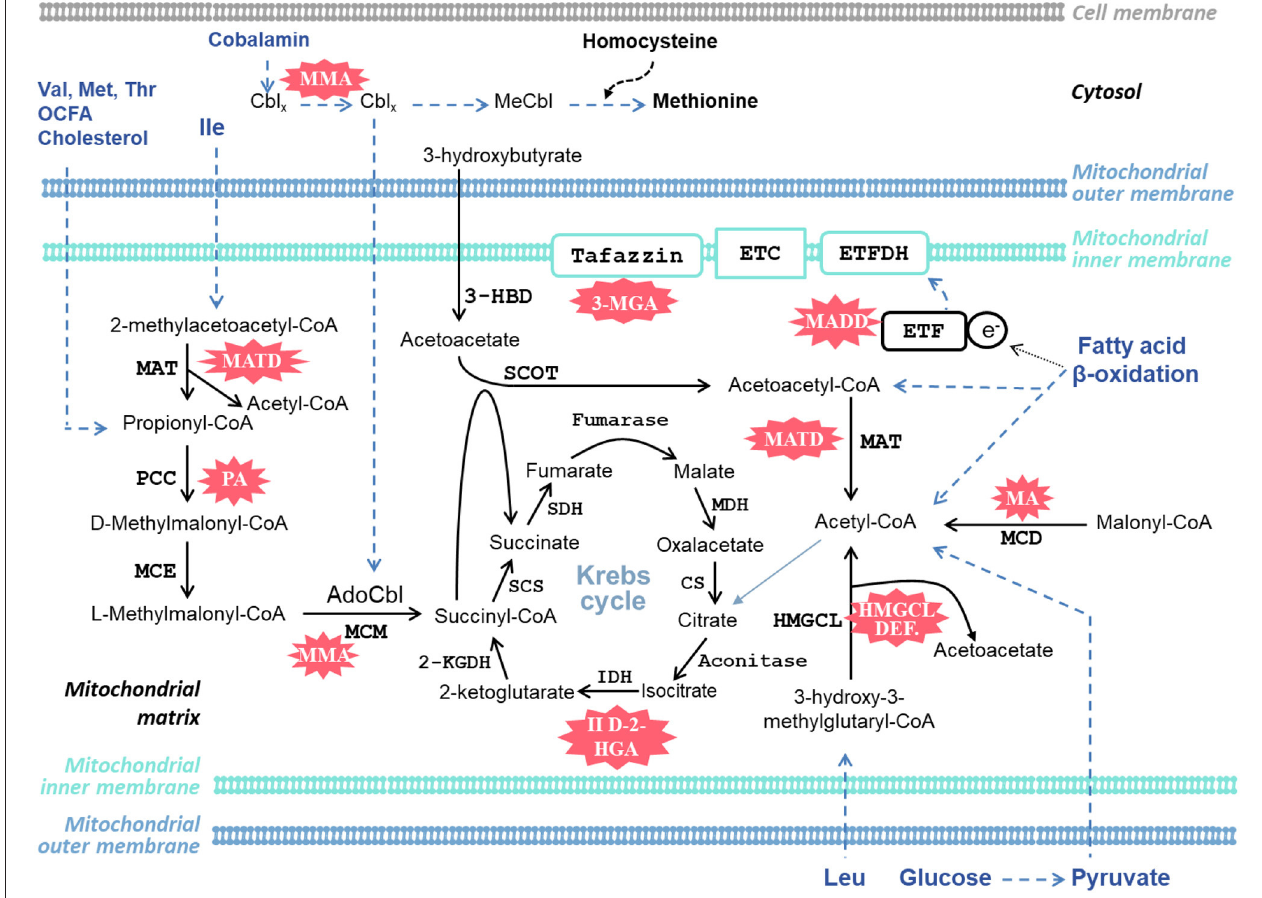
FIGURE 2 | Schematic diagram of selected metabolic pathways in the heart that are affected and implicated in the organic acidemias discussed in this article. AdoCbl, adenosylcobalamin; Cbl, cobalamin; 2-KGDH, 2-ketoglutarate dehydrogenase; CS, citrate synthase; ETC, electron transport chain; ETF, electron-transfer flavoprotein; ETFDH, electron-transfer flavoprotein dehydrogenase; II D-2-HGA, type II D-2-hydroxyglutaric aciduria; 3-HBD, 3-hydroxybutyrate dehydrogenase; HMGCL, 3-hydroxy-3-methylglutaryl-CoA lyase; IDH, isocitrate dehydrogenase; Ile, isoleucine; Leu, Leucine; MA, malonic acidemia; MADD, multiple acyl-CoA dehydrogenase deficiency; MATD, mitochondrial acetoacetyl-CoA thiolase deficiency; MCD, malonyl-CoA decarboxylase; MCE, methylmalonyl-CoA epimerase (methylmalonyl-CoA racemase); MCM, methylmalonyl-CoA mutase; MDH, malate dehydrogenase; MeCbl, methylcobalamin; Met, methionine; 3-MGA, 3-methylglutaconic aciduria; MMA, methylmalonic acidemia; PA, propionic acidemia; PCC, propionyl-CoA carboxylase; SCOT, succinyl-CoA:3-ketoacid CoA transferase; SCS, succinyl-CoA synthetase (succinyl-CoA ligase); SDH, succinate dehydrogenase; Thr, threonine; Val, valine. Cbl x refers to different oxidation states of the central cobalt ion in cobalamin. Blue dashed lines indicate several metabolic